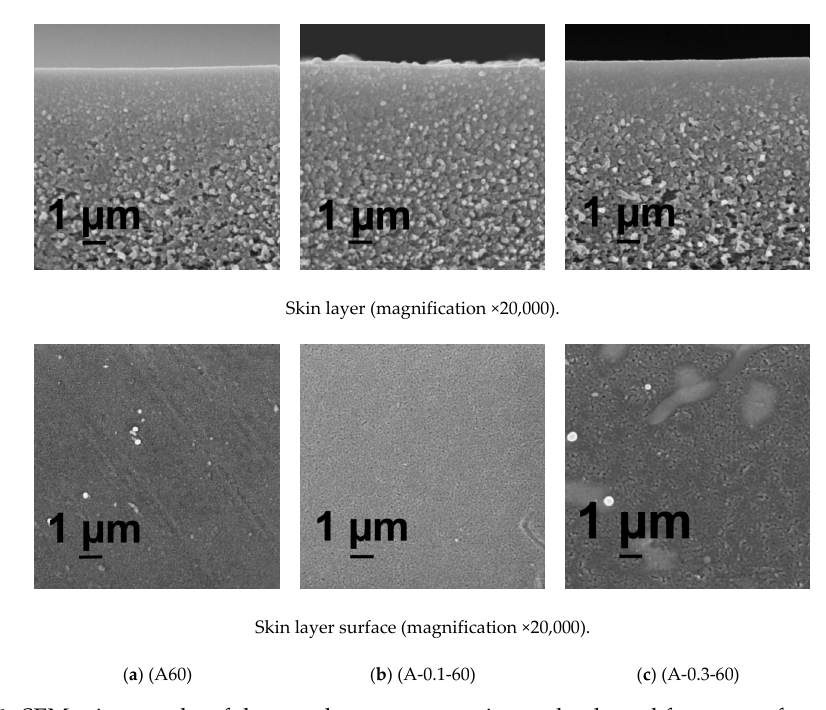
Figure 6. SEM micrographs of the membrane cross-section and enlarged fragment of cross-section, coagulation bath, T = 60 °C, PASA concentration in the coagulant, wt %: ( a ) 0; ( b ) 0.1; ( c ) 0.3.